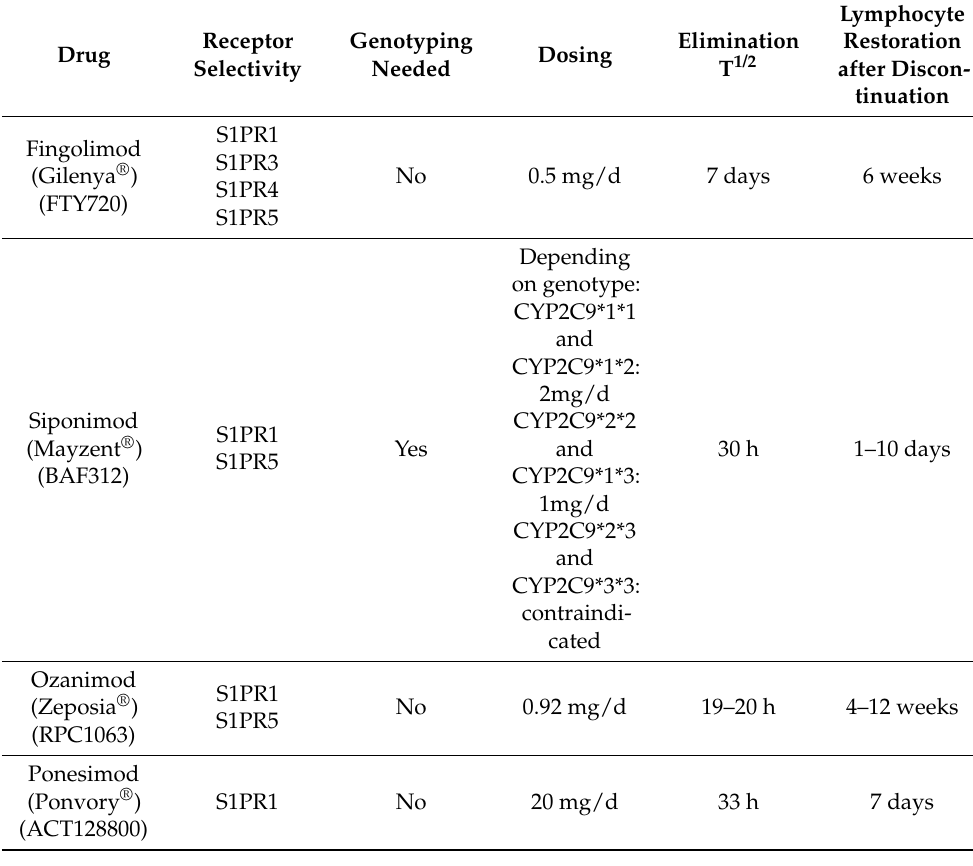
Genotyping Needed